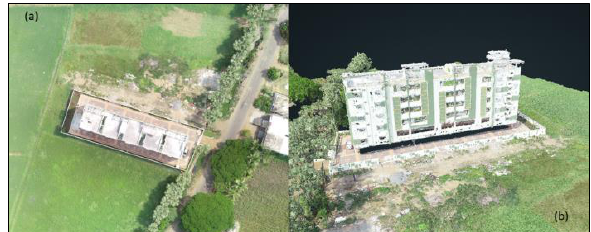
Figure 7: Building outputs generated after data processing(a) Orthomosaic image (b) 3D Building model